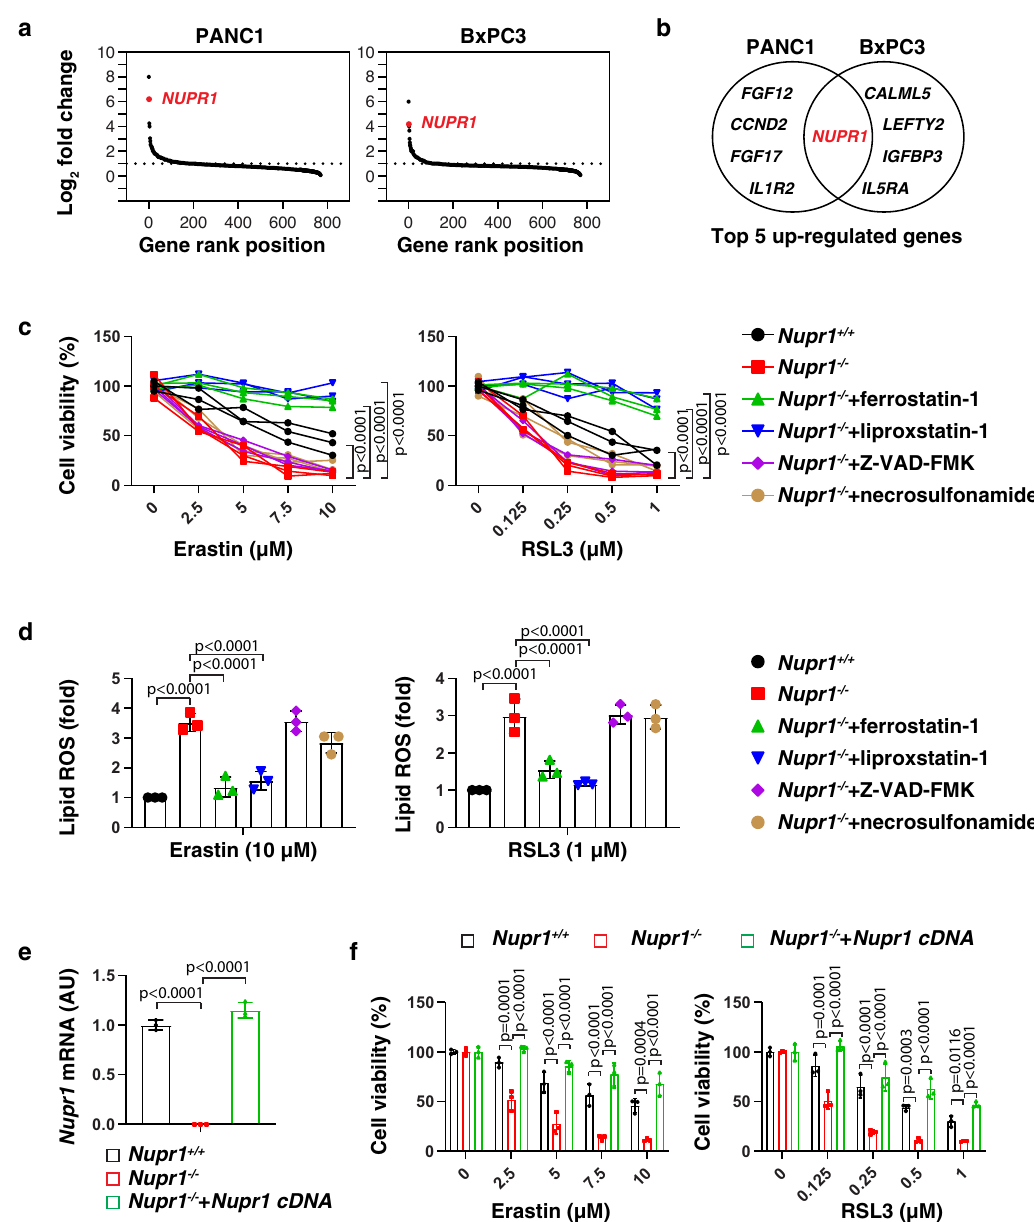
Fig. 1 NUPR1 acts as a repressor of ferroptosis. a A NanoString technology-based screening of differentially expressed tumor-associated genes in PANC1 and BxPC3 cells following treatment with erastin (10 µ M) for 24 h. b Top 5 upregulated genes. c , d Nupr1 + / + and Nupr1 − / − mPDAC cells were treated with erastin or RSL3 in the absence or presence of ferrostatin-1 (1 µ M), liproxstatin-1 (1 µ M), Z-VAD-FMK (10 µ M), or necrosulfonamide (1 μ M) for 24 h, and then cell viability ( c ) and lipid ROS ( d ) was measured ( n = 3 well/group, two-way ANOVA with Tukey ’ s multiple comparisons test on all pairwise combinations). e qPCR analysis of NUPR1 expression in indicated mPDAC cells ( n = 3 well/group, one-way ANOVA with Tukey ’ s multiple comparisons test on all pairwise combinations). f Cell viability of indicated mPDAC cells following treatment with erastin or RSL3 for 24 h ( n = 3 well/group, two-way ANOVA with Tukey ’ s multiple comparisons test on all pairwise combinations). Data in d – f are presented as mean ± SD. The results in c – f are representative of those from 2 to 3 independent experiments with three technical replicates each. The results in a are representative of those from one independent experiment with three technical replicates cells (Fig. 3a). Consistent with the mRNA assay, erastin-induced upregulation in Nupr1 − / − mPDAC cells following erastin or or RSL3-induced protein expression of LCN2 was abolished in Nupr1 − / − mPDAC cells (Fig. 3b). Luciferase reporter gene (Fig. 3c) and chromatin immunoprecipitation (Fig. 3d) assays further revealed that Lcn2 is a direct target gene of NUPR1 in mPDAC cells during ferroptosis. As expected, the knockdown of ATF4 by shRNA suppressed LCN2 mRNA expression in PANC1 cells following erastin or RSL3 treatment (Supplementary Fig. 1e). However, overexpression of ATF4 failed to induce Lcn2